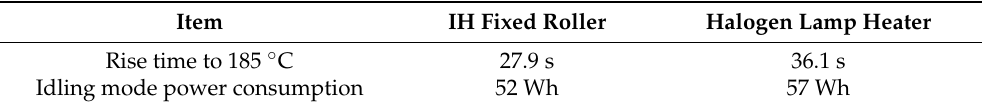
Table 2. Table 2. Characteristics.